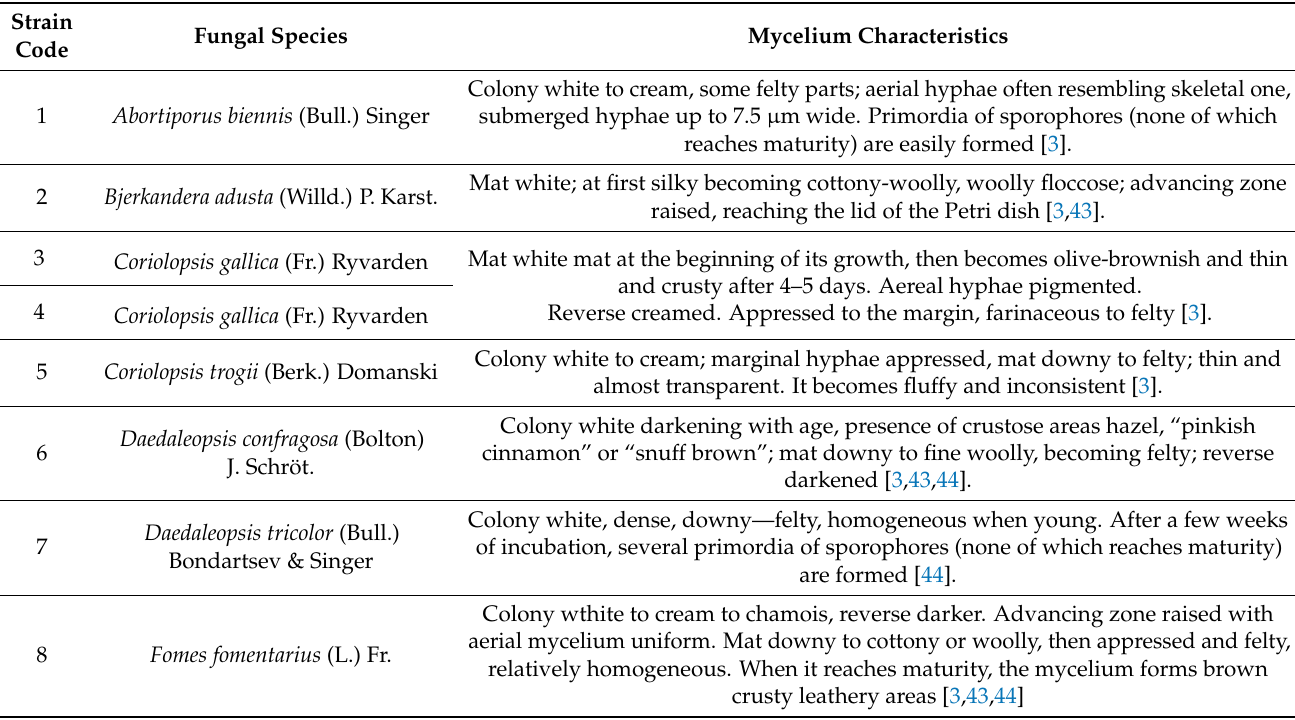
Table 1. WDF chosen for developing mycelium